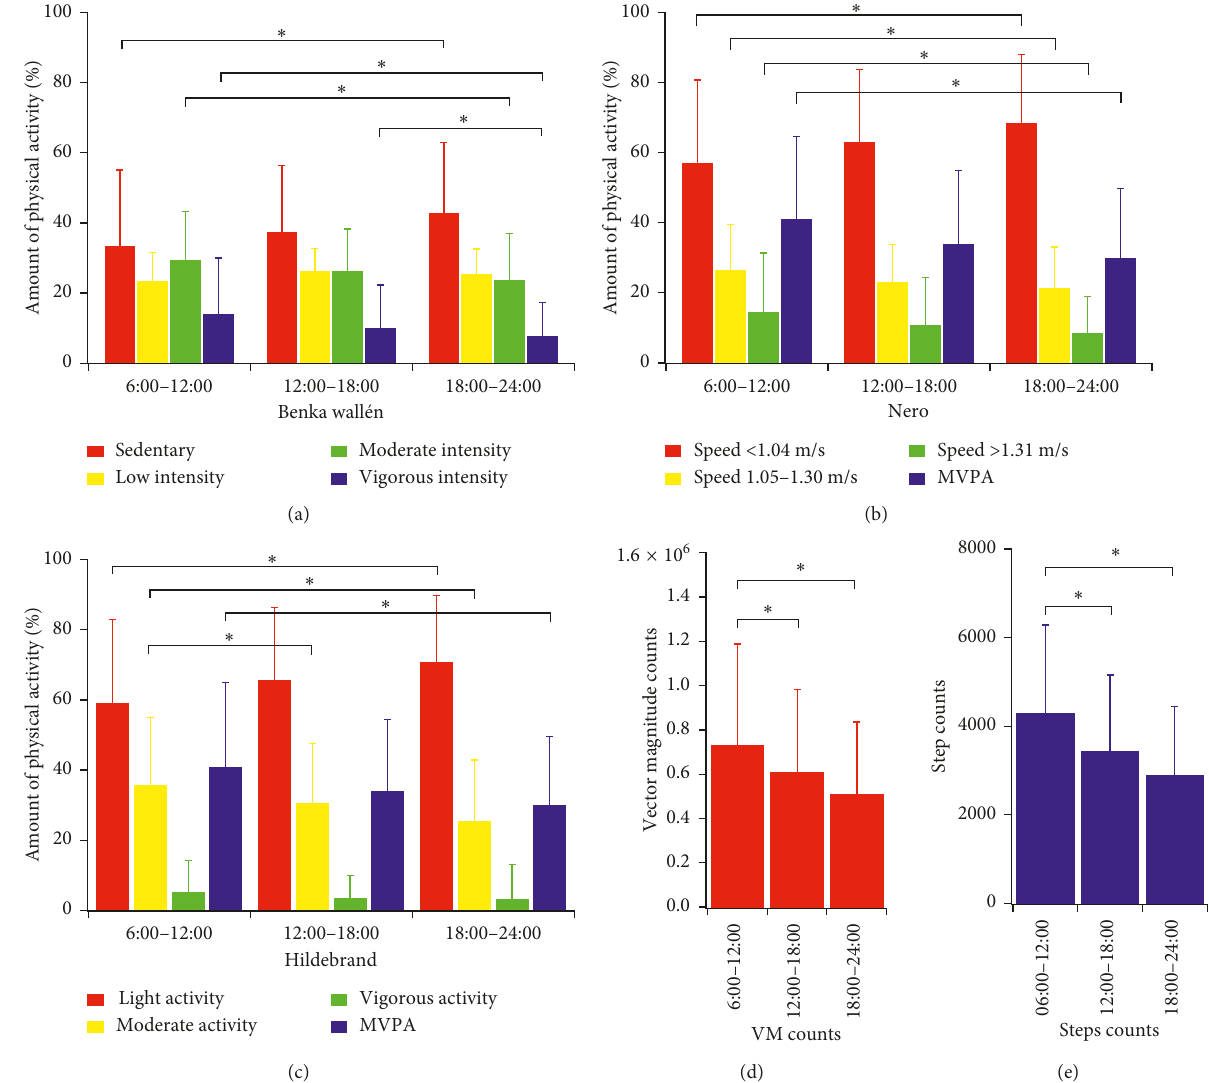
Figure 2: Physical activity amount classified as a function of intensity for the 3 time slots. (MVPA VM vector (cid:31)